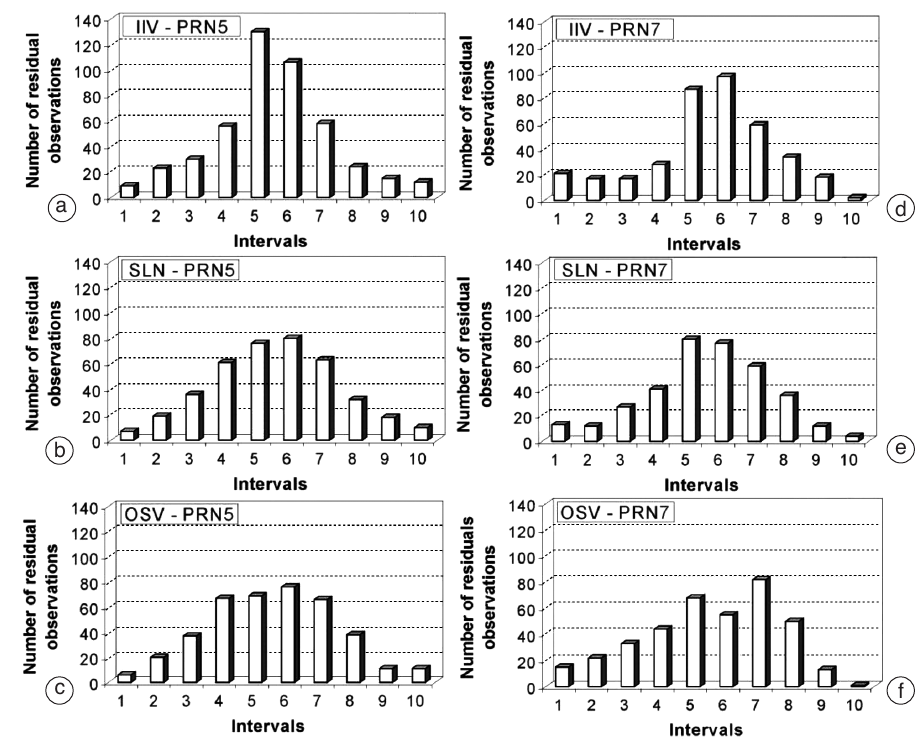
Fig. 7a-f. Histograms representing the number of residuals contained in each of the 10 intervals: 1) r G < r ⎯ G + − 2 σ r G ; 2) r 6) r